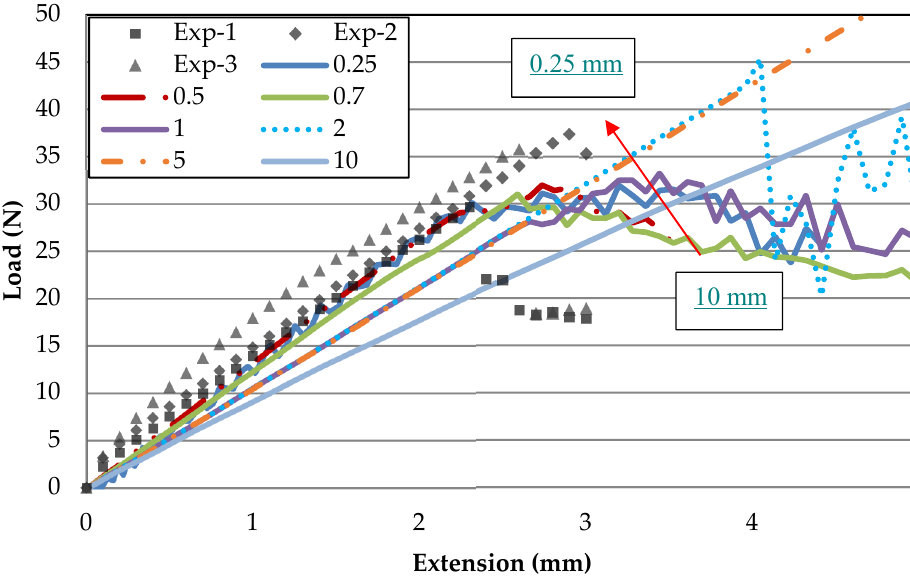
Figure 3. Mesh size effect on Mode-I load–displacement curves.